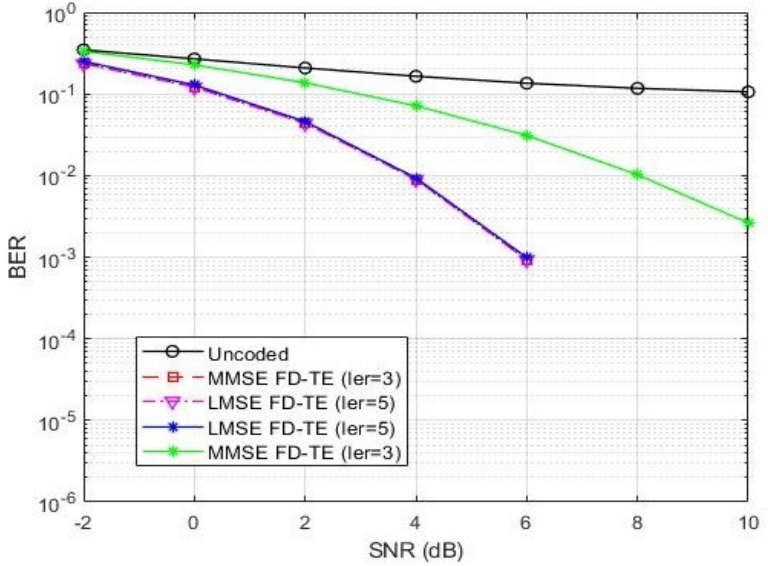
Figure 8. BER performance comparison of the proposed MMSE-FDTE and LMSE equalization algorithms of uplink NB-IoT systems using BPSK with different numbers of iterations.